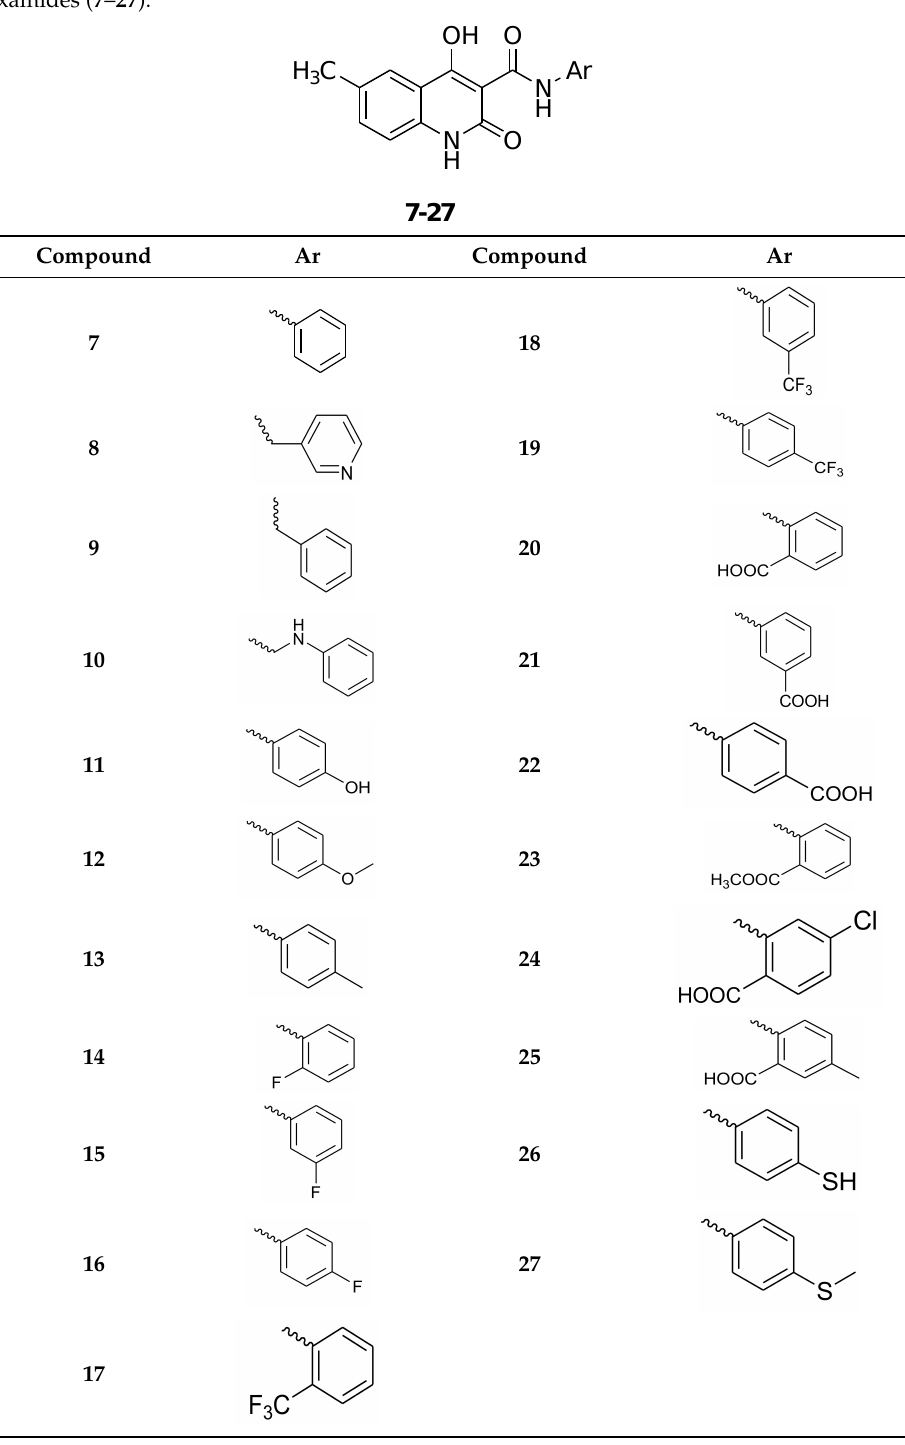
Table 1. Chemical structures of synthesized N -substituted-4-hydroxy-6-methyl-2-quinolone-3- carboxamides ( 7 – 27 ).